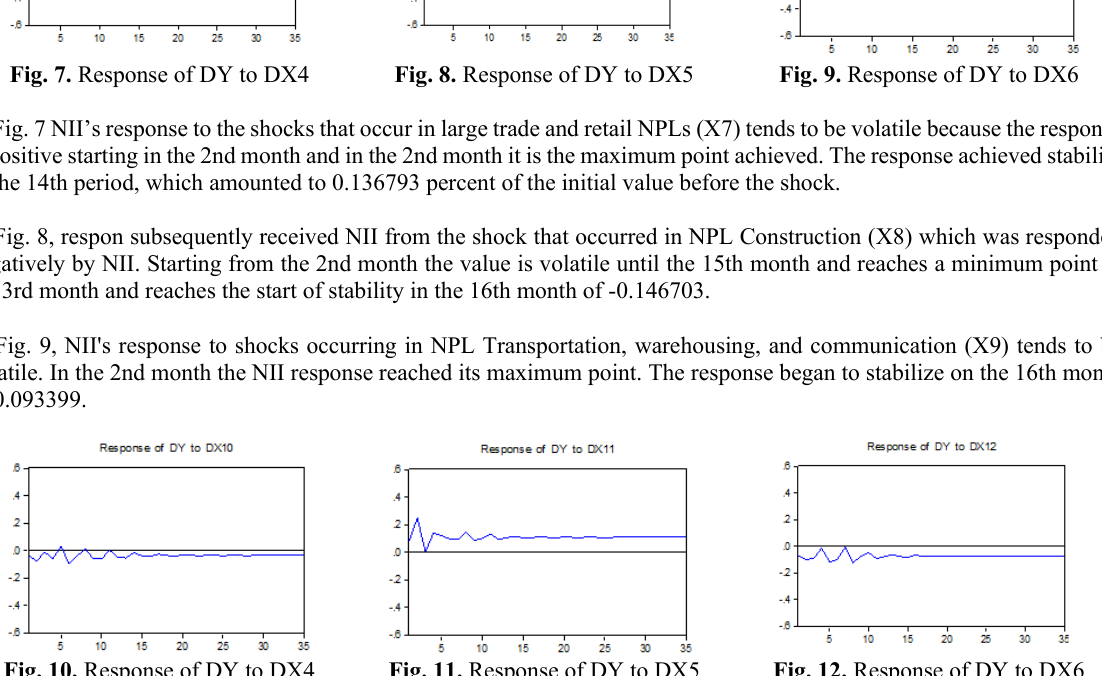
Fig. 10. Response of DY to DX4 Fig. 11. Response of DY to DX5 Fig. 12. Response of DY to